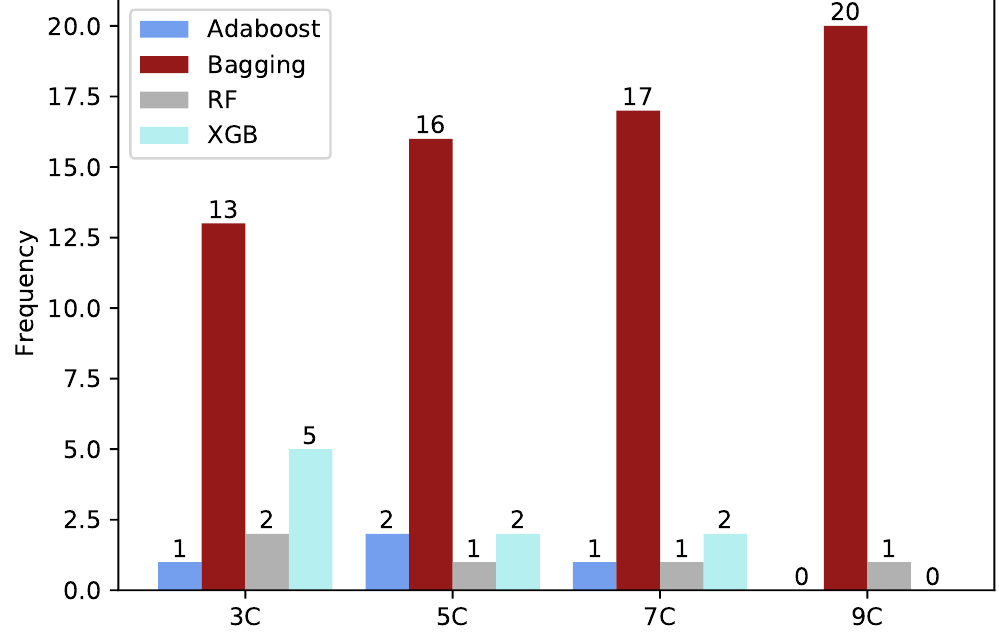
Figure 4. Frequency of the ensemble classifiers in K-Means/Ensemble classifiers (KME) for different numbers of